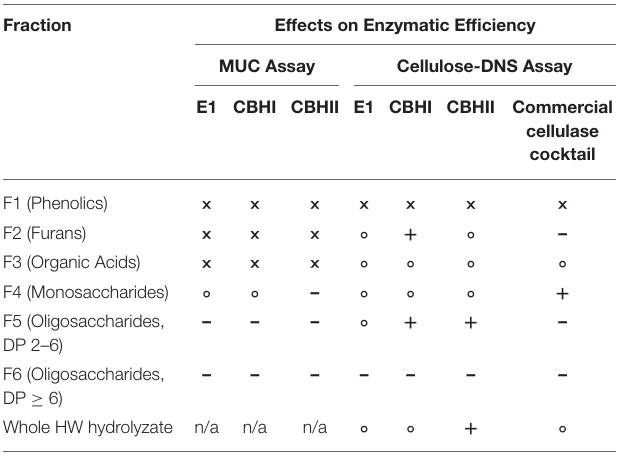
TABLE 5 | A summary of the effects of HW fractions on cellulase enzymatic efficiency.